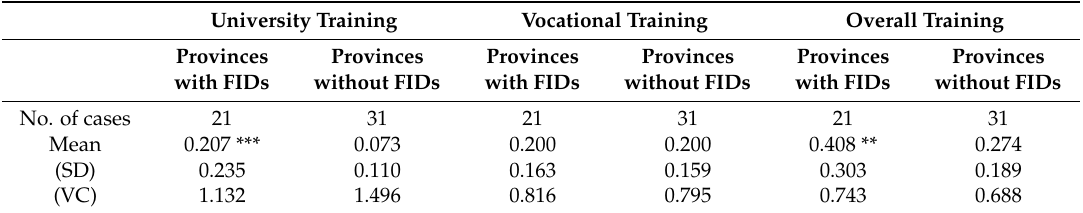
Table 5. Comparison between provinces with/without districts and the training offer of the food industry. University Training Vocational Training Overall Training Provinces Provinces Provinces Provinces Provinces Provinces with FIDs without FIDs with FIDs without FIDs with FIDs without